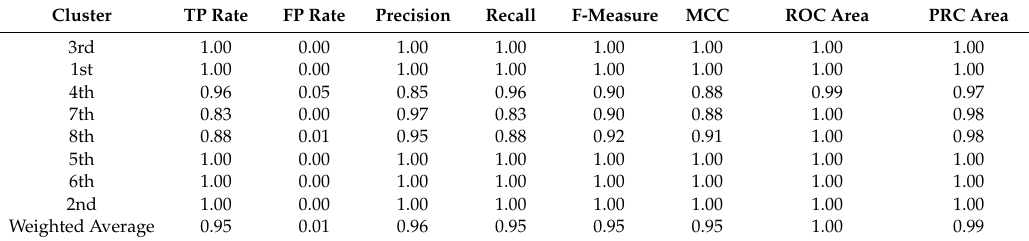
Table 4. Cluster assignment detailed accuracy by class. TP rate: Rate of true positives; FP rate: Rate of false positives; precision: Proportion of instances that are truly of a class divided by the total instances classified as that class; F-measure: Combined measure for precision and recall; ROC area: Receiver operating characteristics measurement area; PRC area: Precision recall area.